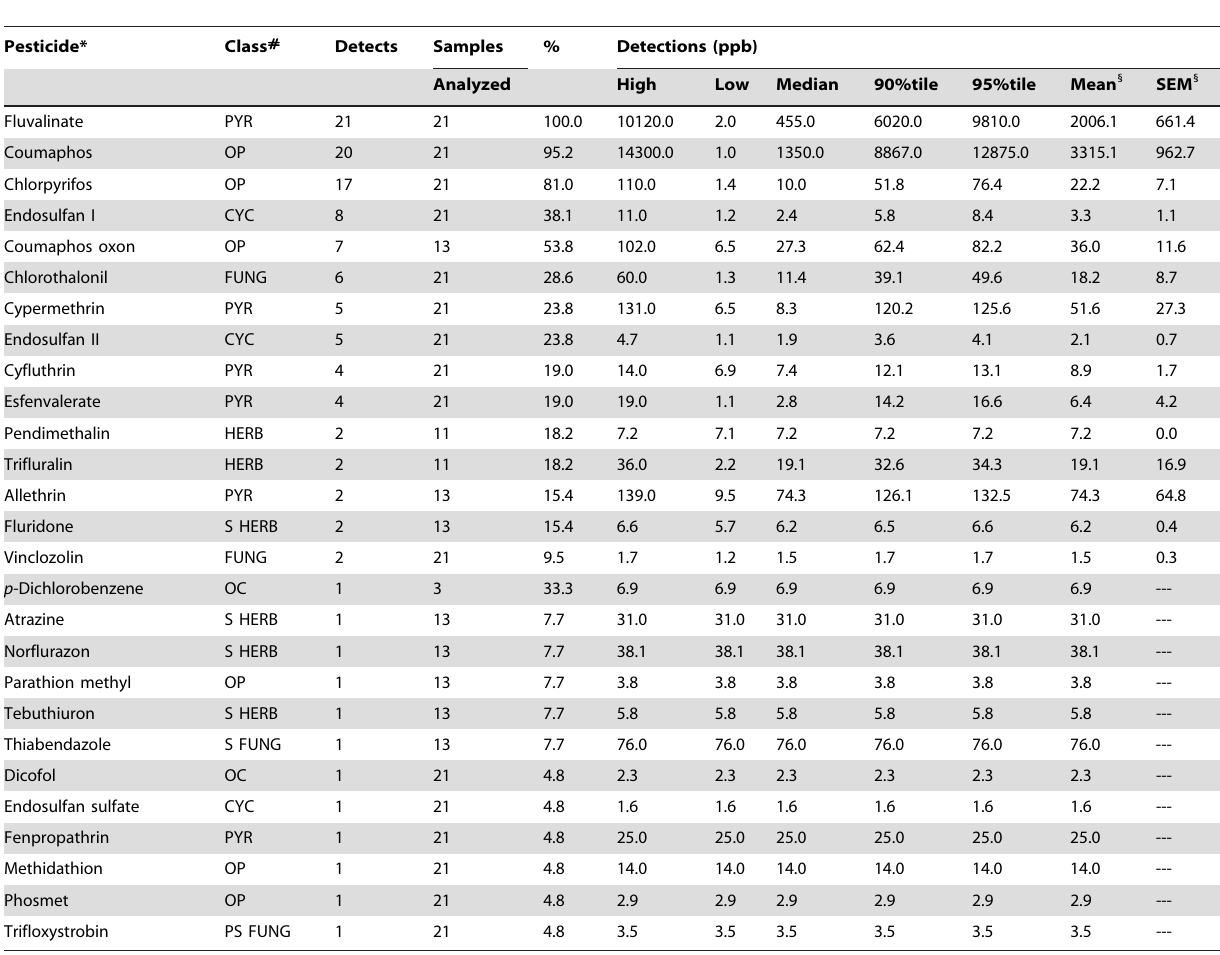
Table 5. Summary of pesticide detections in foundation samples from North American honey bee colonies.